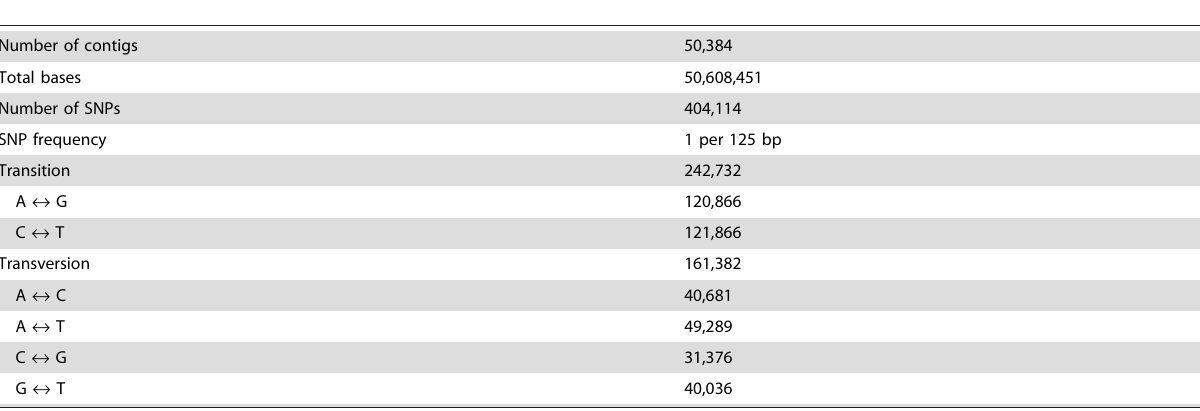
Table 7. Summary of putative SNPs identified using CLC Genomics Workbench.